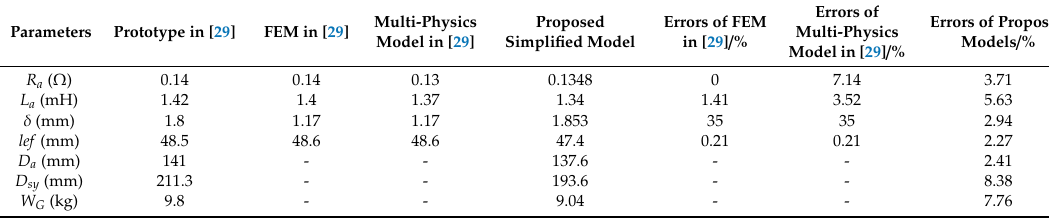
Table 4. Model results and error comparisons.